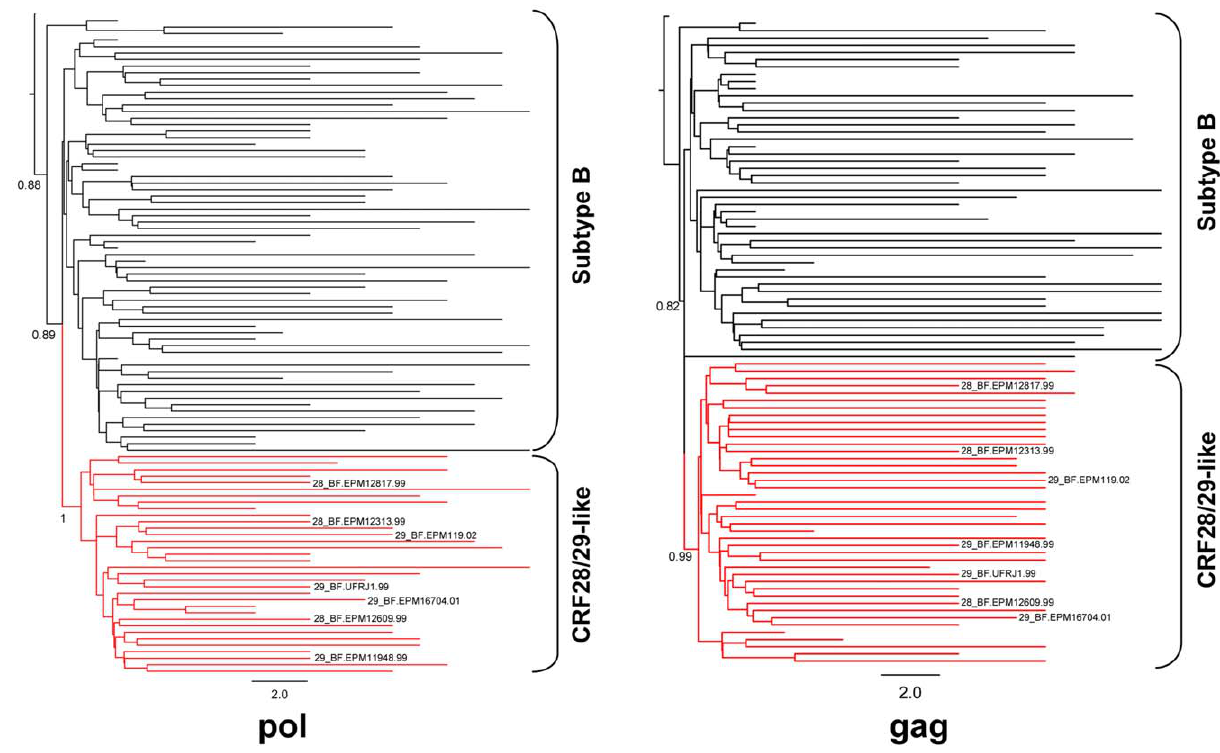
Figure 2. Bayesian evolutionary analysis by sampling phylogenetic trees of Brazilian subtype B and CRF28/29_BF-like HIV-1. The maximum clade credibility phylogenetic trees of the pol and gag genes are shown. The brackets indicate the monophyletic group formed by each lineage. The subtype B lineage is in black, and the CRF28/29_BF-like lineage is in red. Positions of the CRF28_BF and CRF29_BF references are indicated. Posterior probability values greater than 0.8 are shown at nodes.